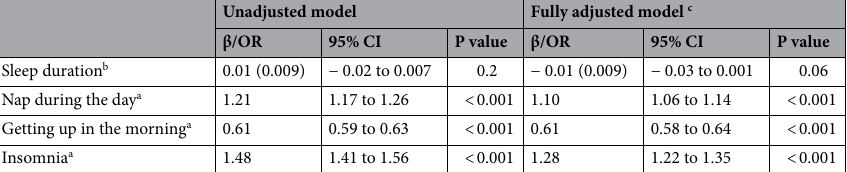
Table 3. Regression models for the association between RA and sleep. a Logistic regression with OR. b Linear regression with standardized betas and SE. c Adjusted for the covariates of age, sex, ethnicity (White British vs Other), deprivation index, smoking status, BMI, alcohol intake and cardiometabolic